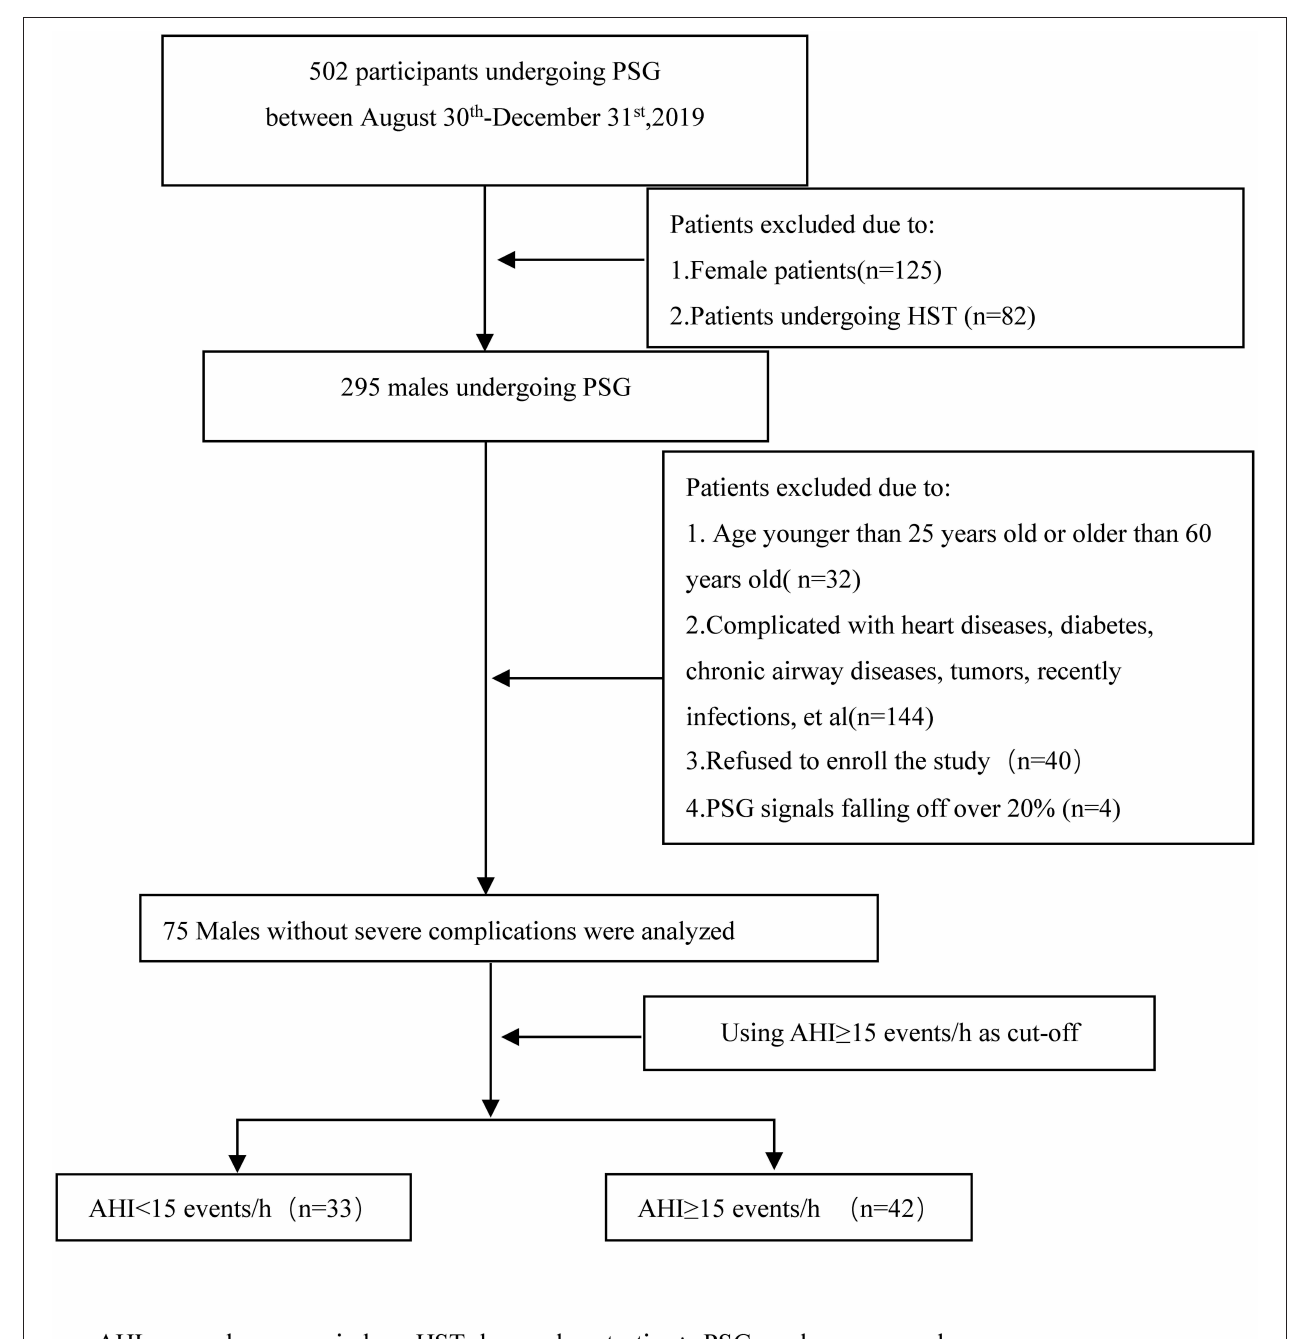
FIGURE 1 | Flow diagram of the participants during the study. AHI, apnea hypopnea index; HST, home sleep testing; PSG, polysomnography.